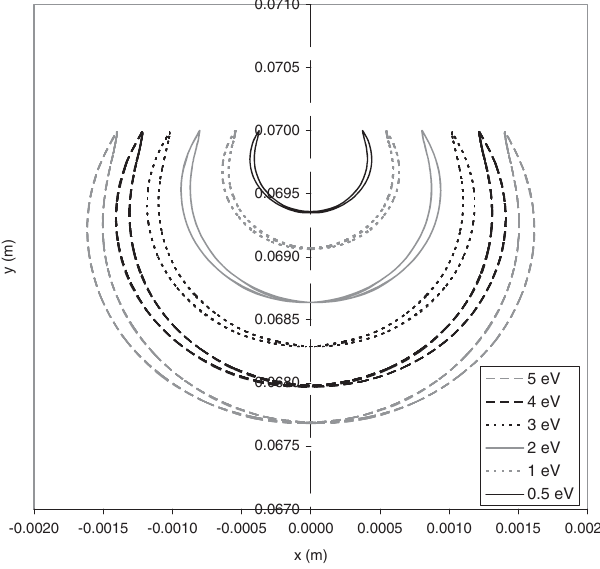
FIG. 8. Electron trajectories for various initial electron